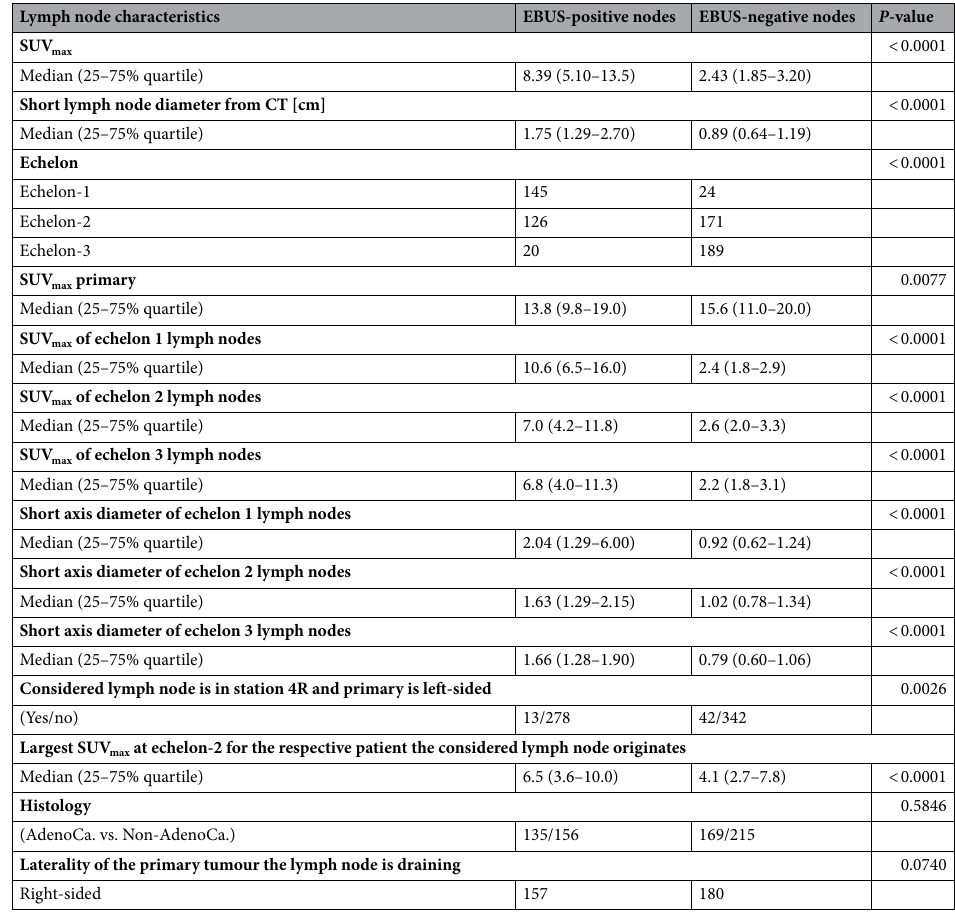
Table 1. Characteristics for 675 EBUS- und PET-tested lymph nodes from 180 patients with locally advanced NSCLC receiving definitive or neoadjuvant radiochemotherapy. All numbers represent lymph node counts, except in the rows with a quantitative value as SUV max , SUV max of primary tumour and shorter diameter of EBUS-positive nodes. Continuous variables were compared by Kruskal–Wallis test. Nominal variables were compared by exact chi-square